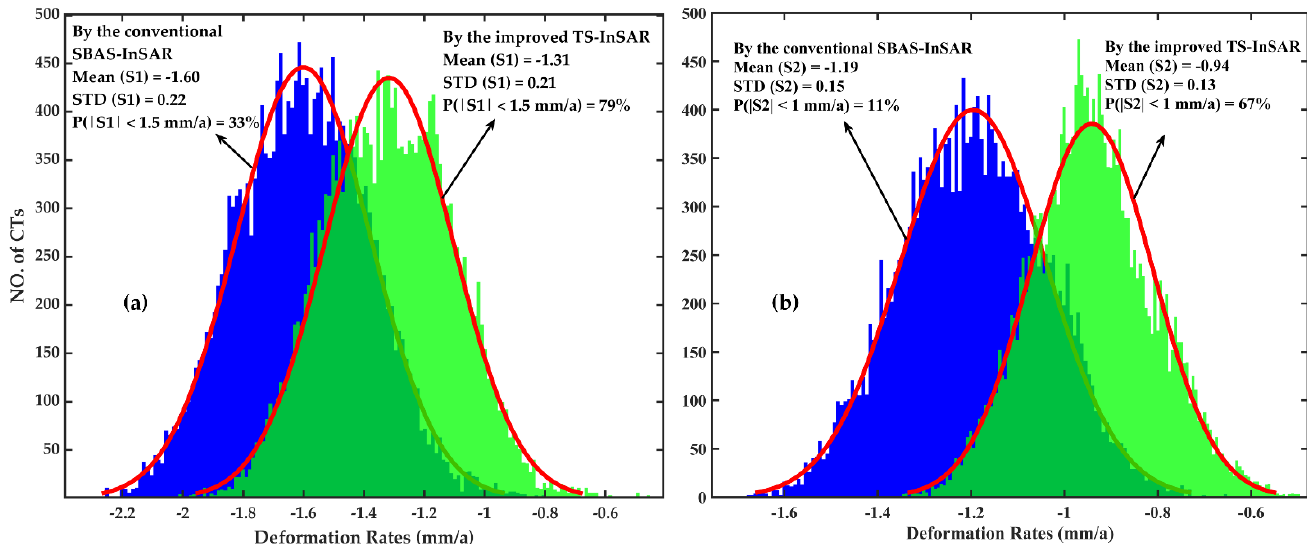
Figure 9. The two subplots are the histogram statistics of the deformation velocity, ( a ) is the results derived by the conventional SBAS-InSAR and the improved TS-InSAR in area S1, respectively, and ( b ) is the results derived by them in area S2.